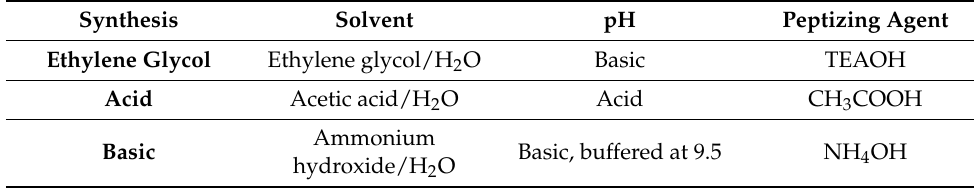
Table 1. Types of syntheses used for the preparation of anatase NPs.